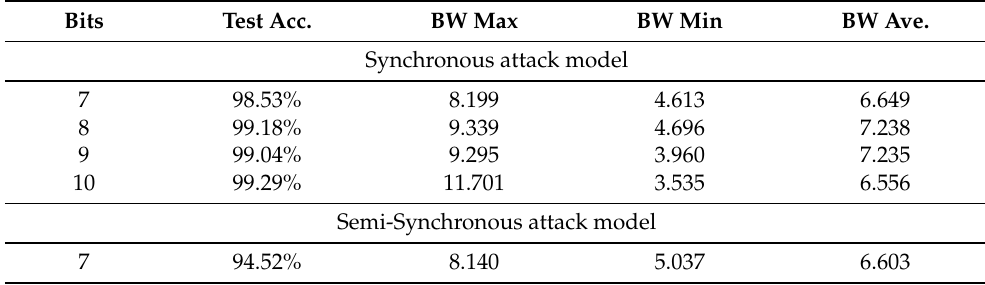
Table 2. The results of synchronous and semi-synchronous attack models, where BW stands for bandwidth